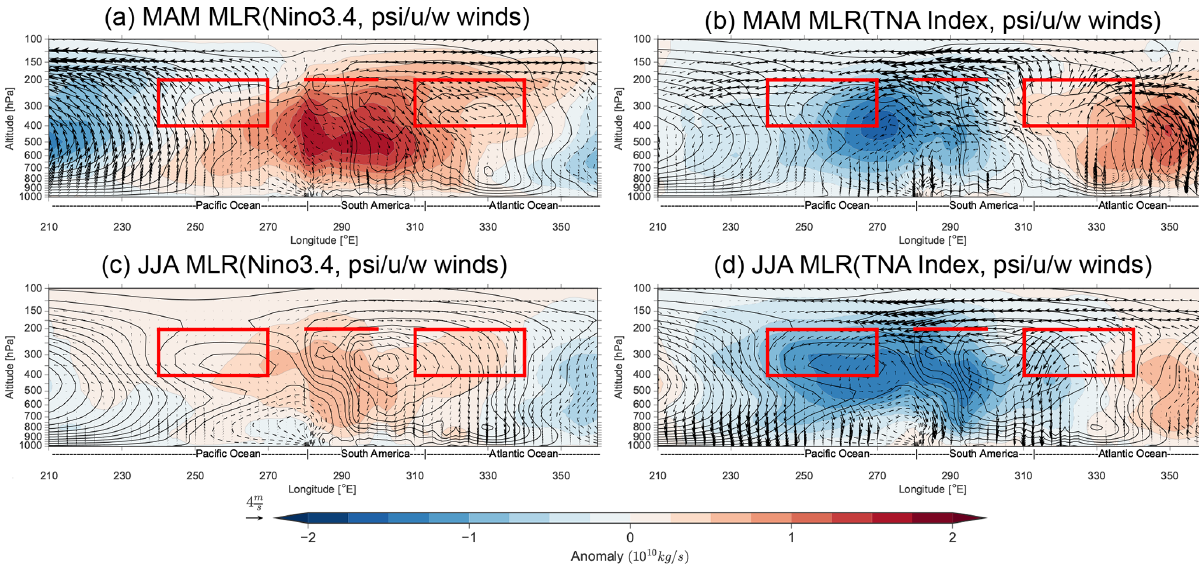
Figure 2. Pointwise multiple linear regression coefficients for the MAM (a, b) and JJA (c, d) zonal mass streamfunction (shading) and u and w winds components (vectors) on the MAM TNA SSTA and DJF Niño3.4 standardized indices. Contours represent the zonal mass streamfunction climatology (in intervals of 1 . 5 × 10 10 kgs − 1 ), and winds are scaled by dividing the vertical velocity by 6 . 5 × 10 − 3 . Red rectangles over the Pacific and Atlantic represent the Walker index, while the horizontal line at 290 ◦ E represents the Caribbean RWS index. Data from